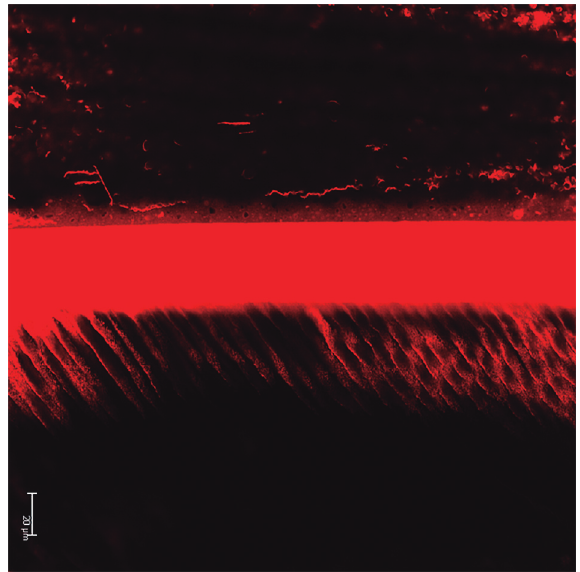
Figure 4- Interface aspect of bonding system to enamel surface (control). Tags are presented in homogeneous extent